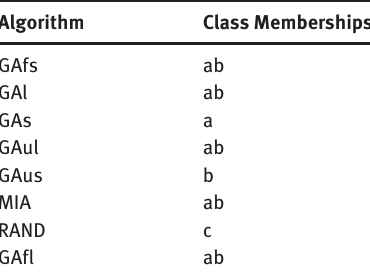
Table 10. Length 17 64 PSK: Tukey HSD Class